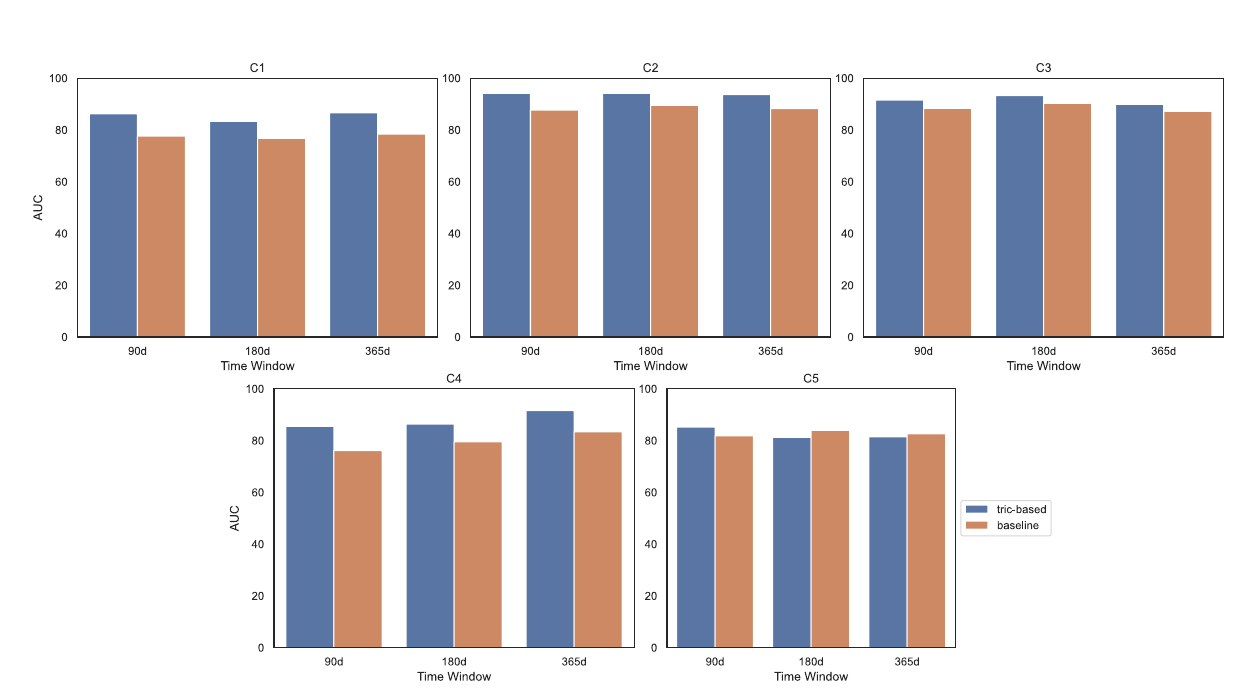
Figure 9. Comparative plot of AUC results obtained by the baseline vs the triclustering-based classifier. Blue bars are referred to triclustering-based classifier results while orange bars are referred to the